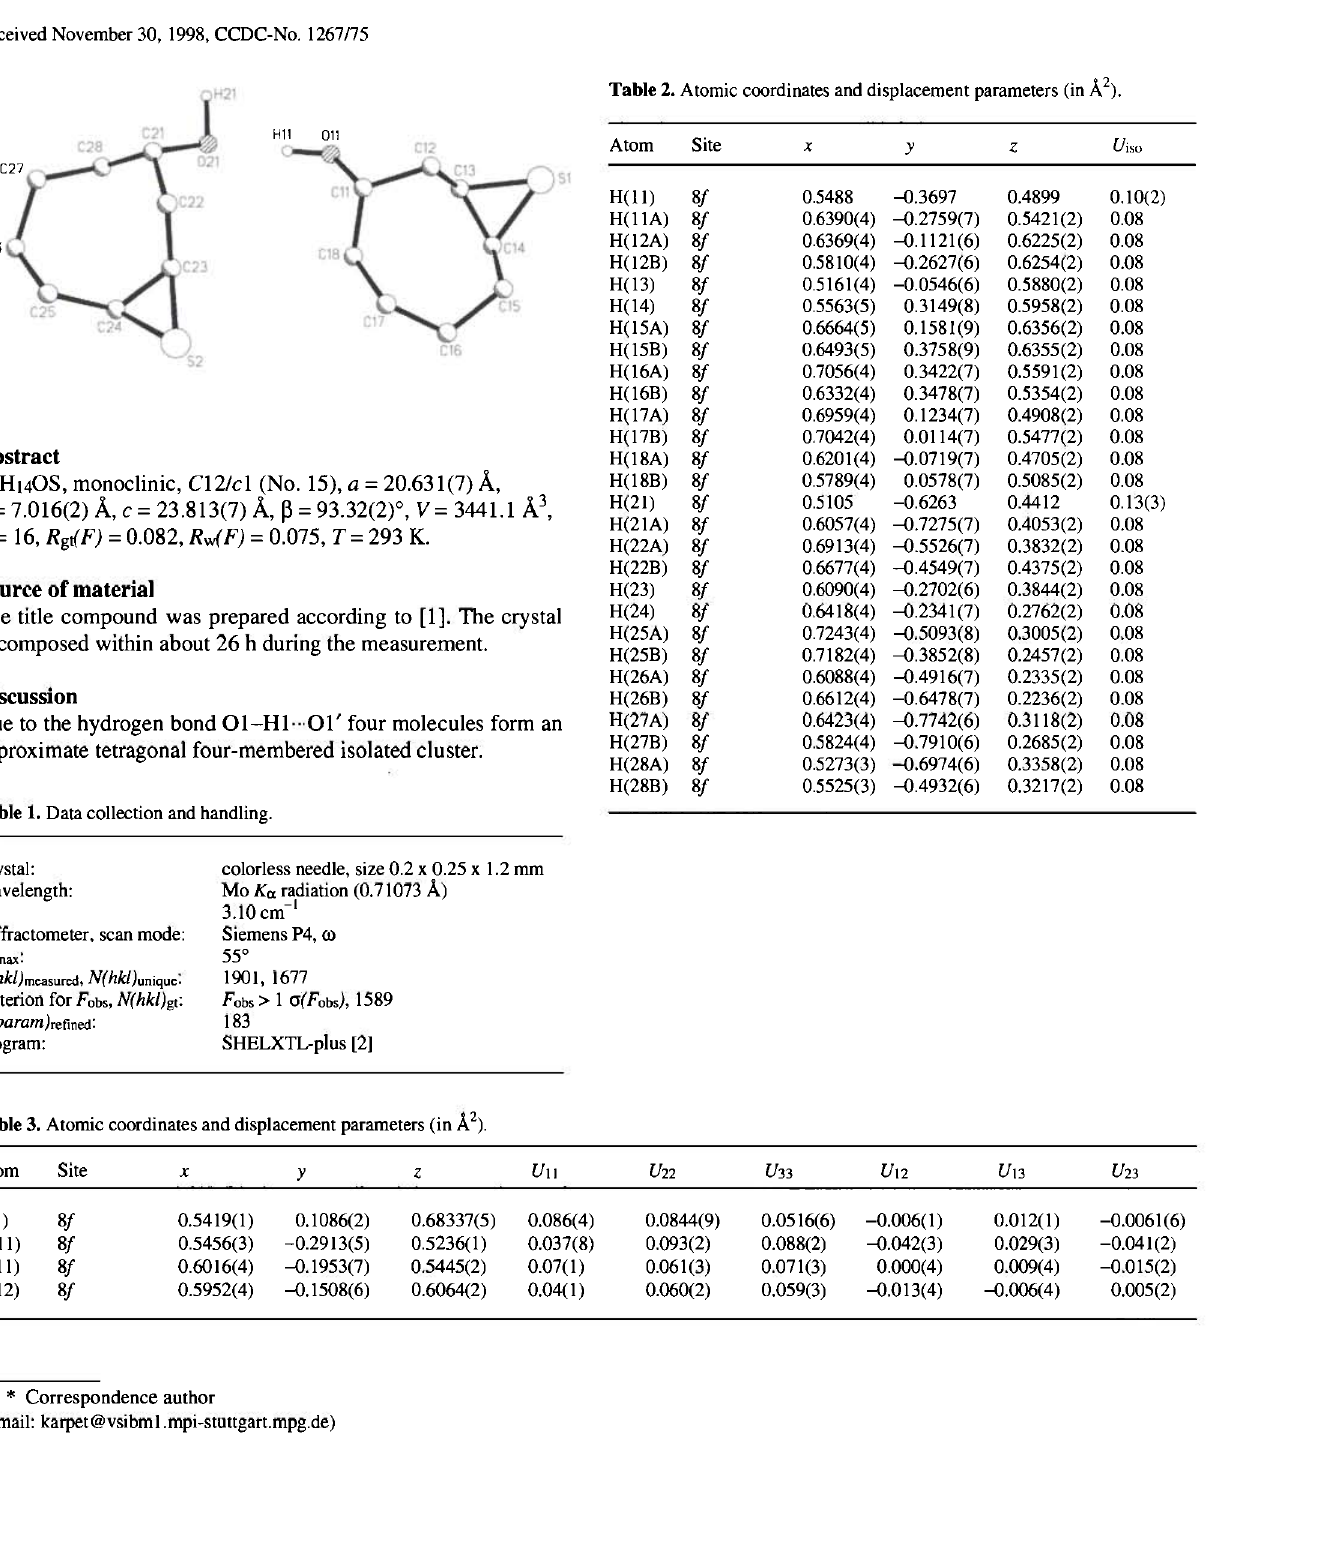
Table 3. Atomic coordinates and displacement parameters (in Ä 2